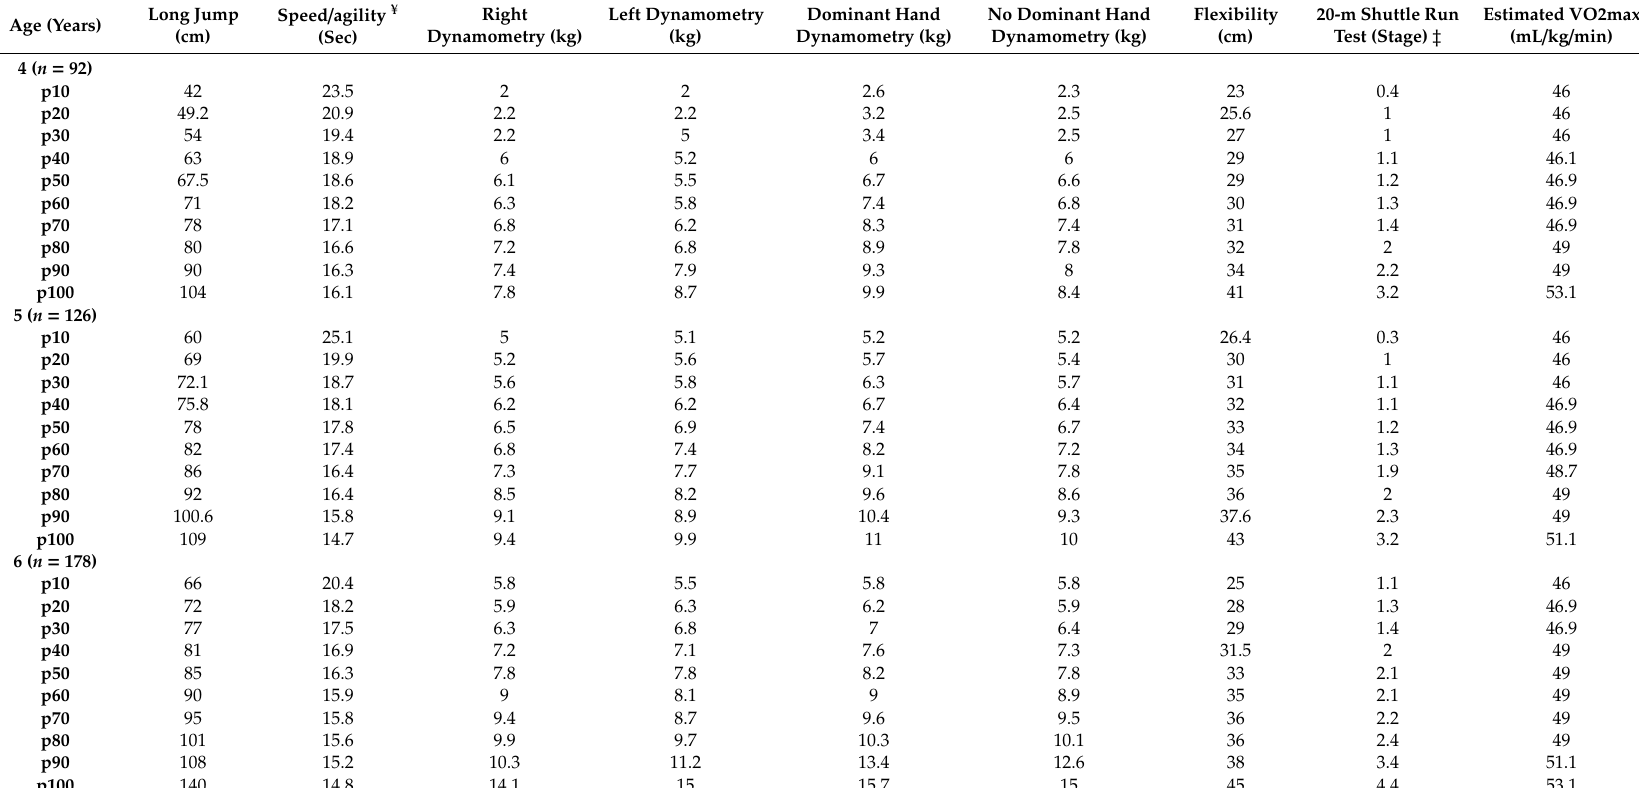
Table 5. Percentile values for girls in fitness